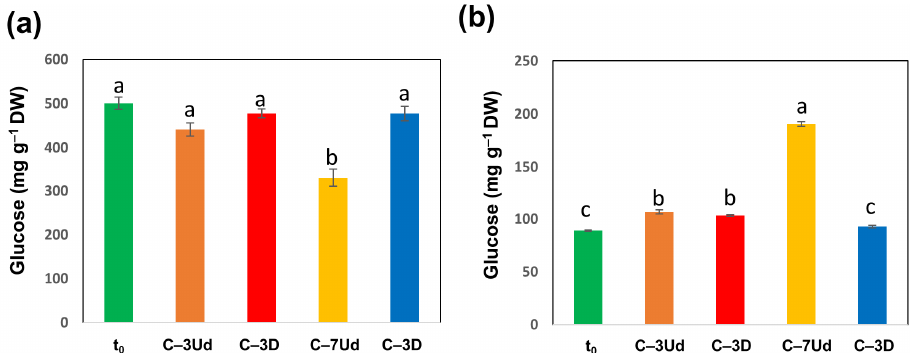
Figure 8. Concentrations of starch ( a ) and soluble carbohydrates ( b ) in the cotyledons. Concentrations were calculated as milligrams of glucose per gram of dry weight (DW). Data are the means of three replicates ± SE. Different letters indicate significant differences according to the HSD post hoc test ( α = 0.05).